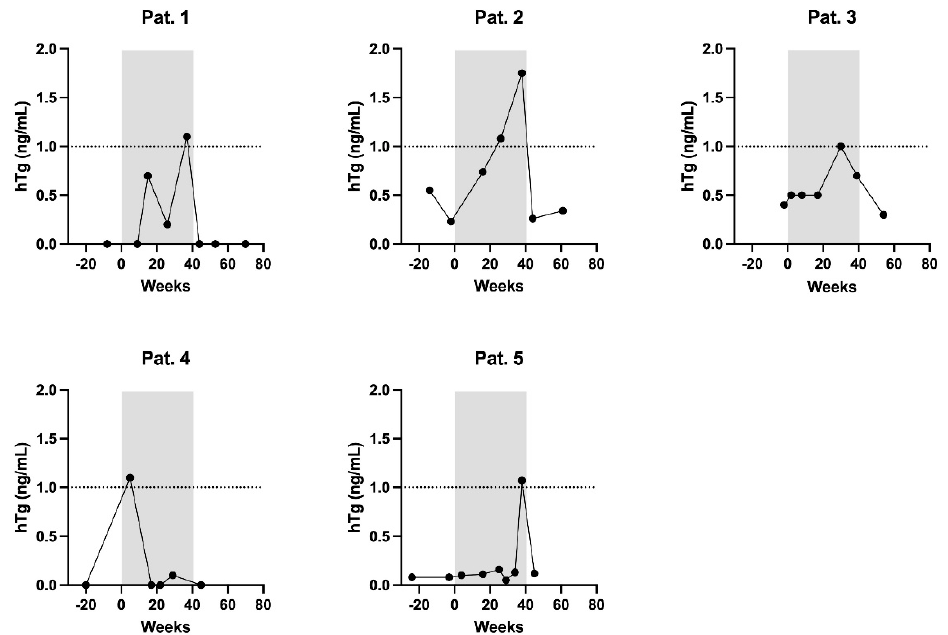
Figure 2. The evolution of the hTG over time of 5 patients with increased hTg ≥ 1 ng/mL.